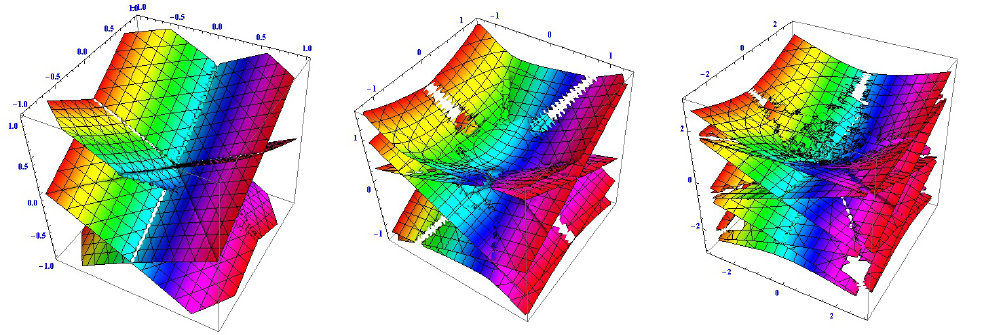
Figure 3. Enneper algebraic maximal surfaces ( Left ): Q 1 ( x , y , z ) = 0, ( Middle ): Q 2 ( x , y , z ) = 0, ( Right ): Q 3 ( x , y , z ) =